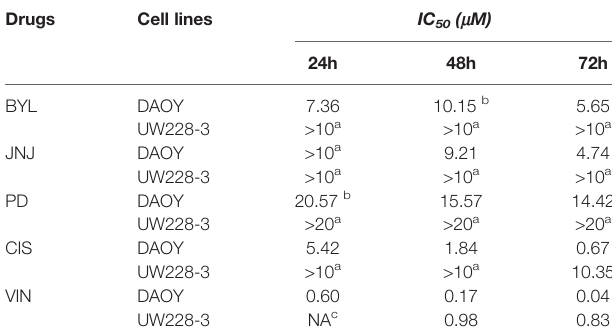
TABLE 1 | Estimation of inhibitory concentration 50% (IC50) based on WST − 1 viability analysis following treatment with the PI3K inhibitor (BYL719), the